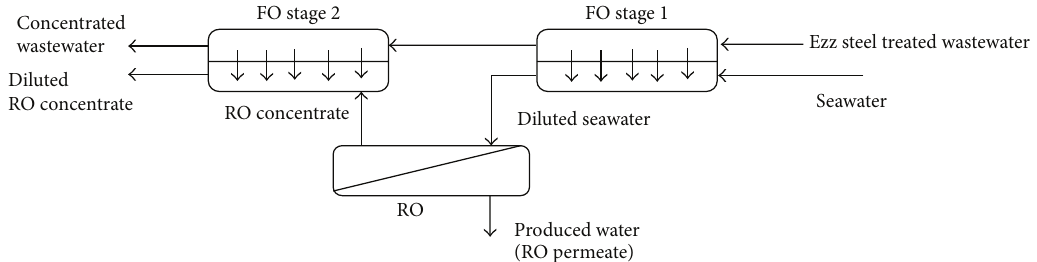
Figure 4: Proposed FO/RO plant for seawater desalination using Ezz Steel treated wastewater.